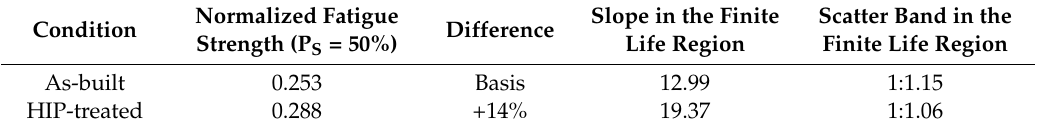
Figure 4. SN-curves for the as-built and HIP condition. Table 2. Statistically evaluated SN-curve parameters for both test series.